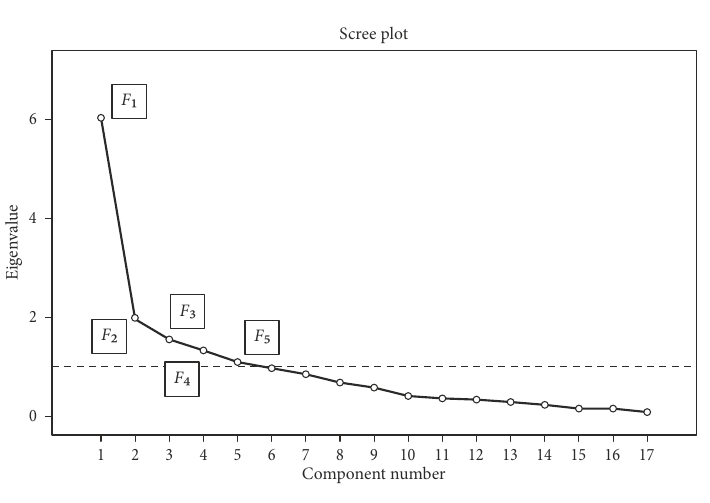
Fig. 3. Scree plot for location factors Note: